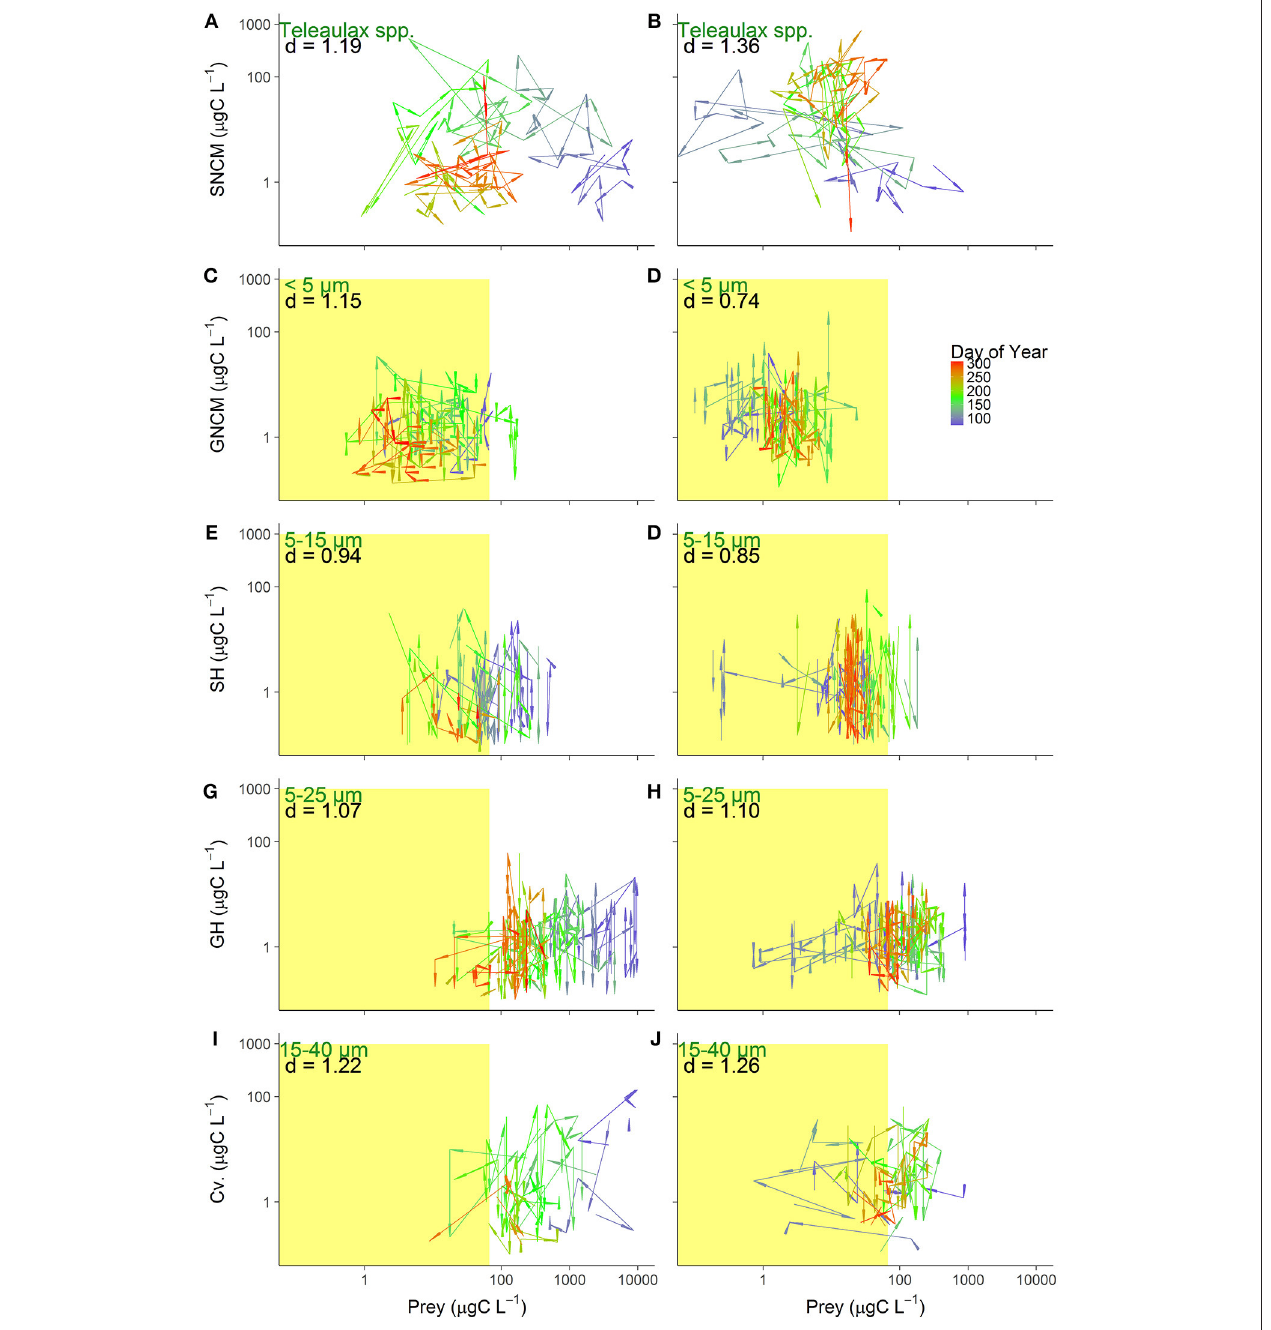
FIGURE 6 | Prey-predator biomass dynamics for the five trophic strategies in 2016 (left) and 2017 (right): SNCM, Specialist Non Constitutive Mixotroph (A,B) , GNCM, Generalist Non Constitutive Mixotroph (C,D) , SH, Selective Herbivore (E,F) , GH, Generic Herbivore (G,H) , and Cv, Carnivore (I,J) . Arrows represent the distance between observations (Euclidean distance) and color gradient indicate the day of year. Text depicts the phytoplankton prey assigned for each predator group (green), and the average Euclidean distance (d) between observation in the productive season of each year (black). Right limits of the yellow colored area indicate the half-saturation constant of food density (Km), and the observations to the left, within the colored area, indicate potential food limitation (except for SNCM, see explanation in Figure 5 ). the increasing proportion of large heterotrophic dinoflagellates might indicate a change in ecological strategy which aims to avoid competition with ciliates that graze on smaller